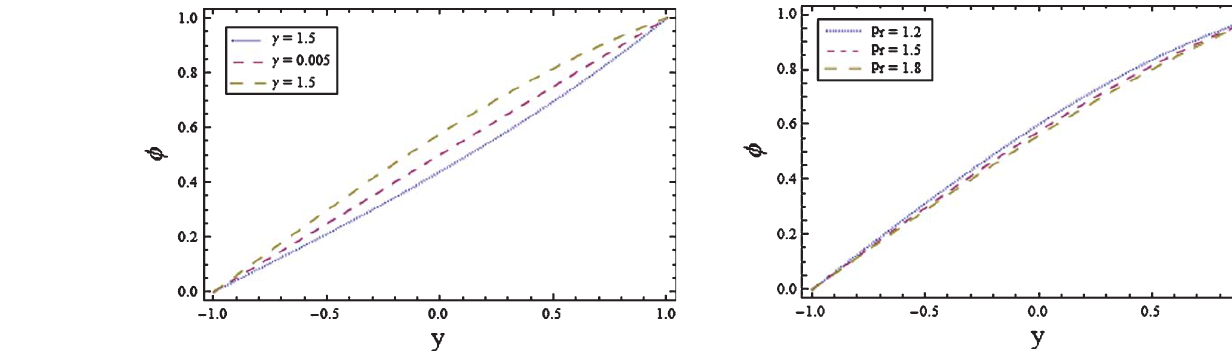
Fig. 16. Plot of concentration φ for various values of the Prandtl number Pr with (cid:15) = 0 . 1, x = 0 . 1, t = 0 . 1 , Sr = 2 ,γ = 1 . 5 ,Sc = 2 and Du = 2 .